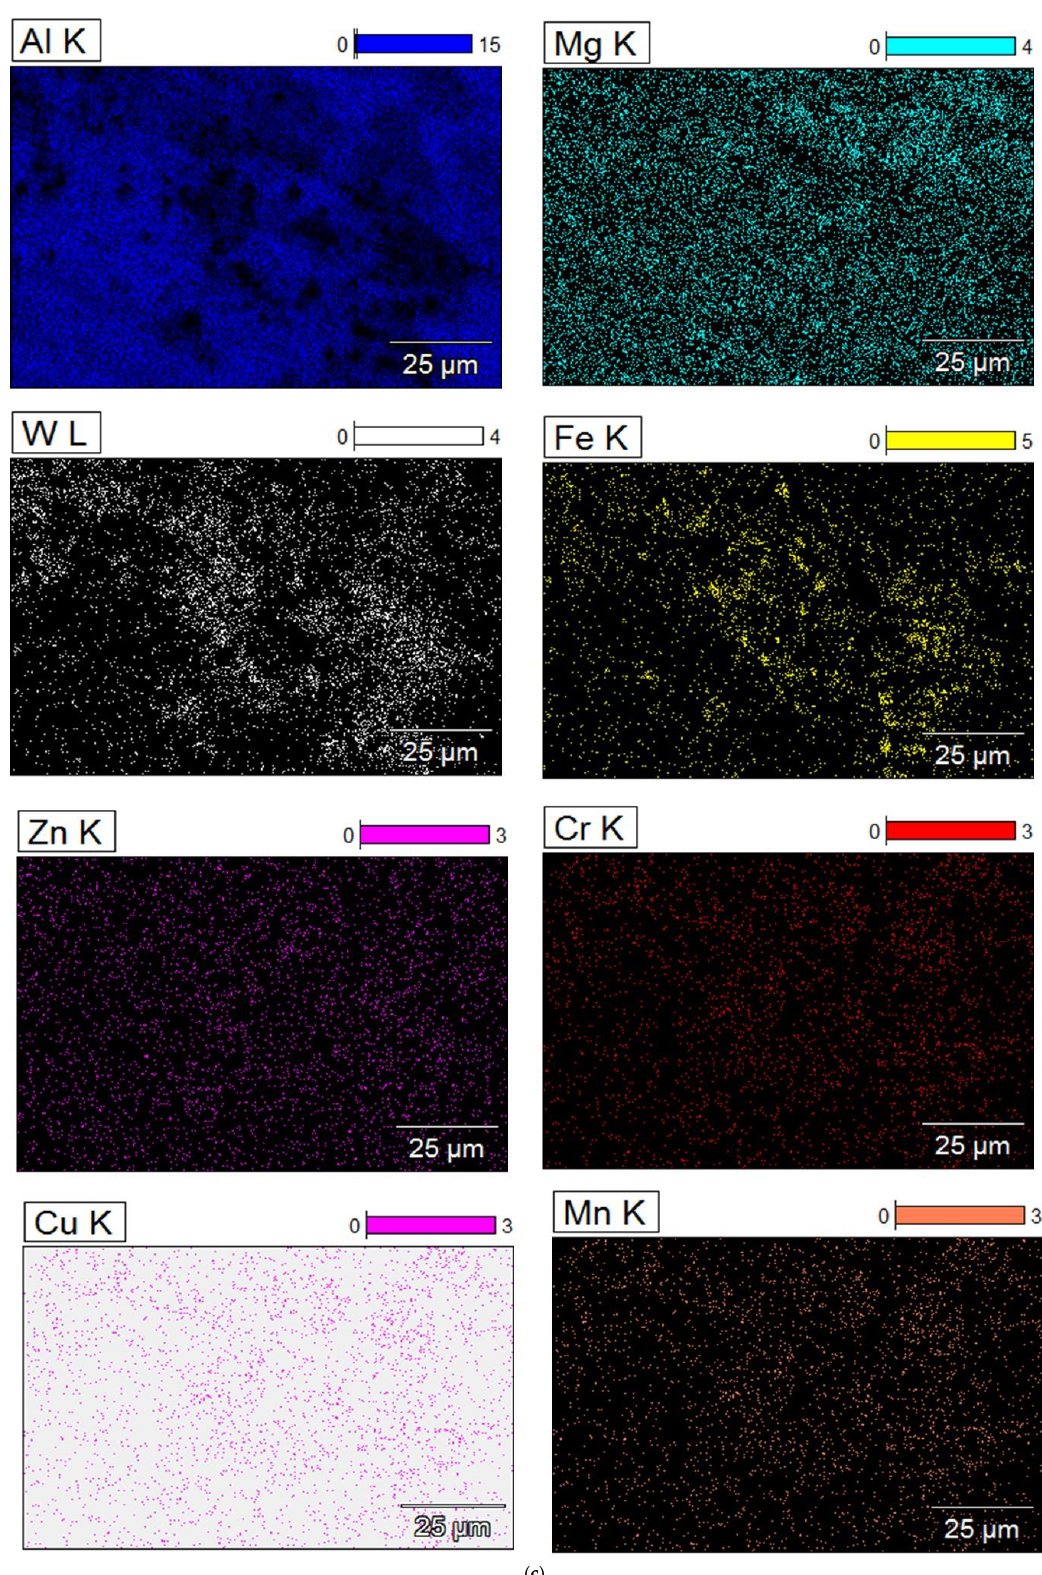
Figure 3. ( a ) EDAX profile of composite. ( b ) Distribution of WC in Al7075-WC composites. ( c ) SEM-MAP distribution alloying element on AA7075-WC composites.